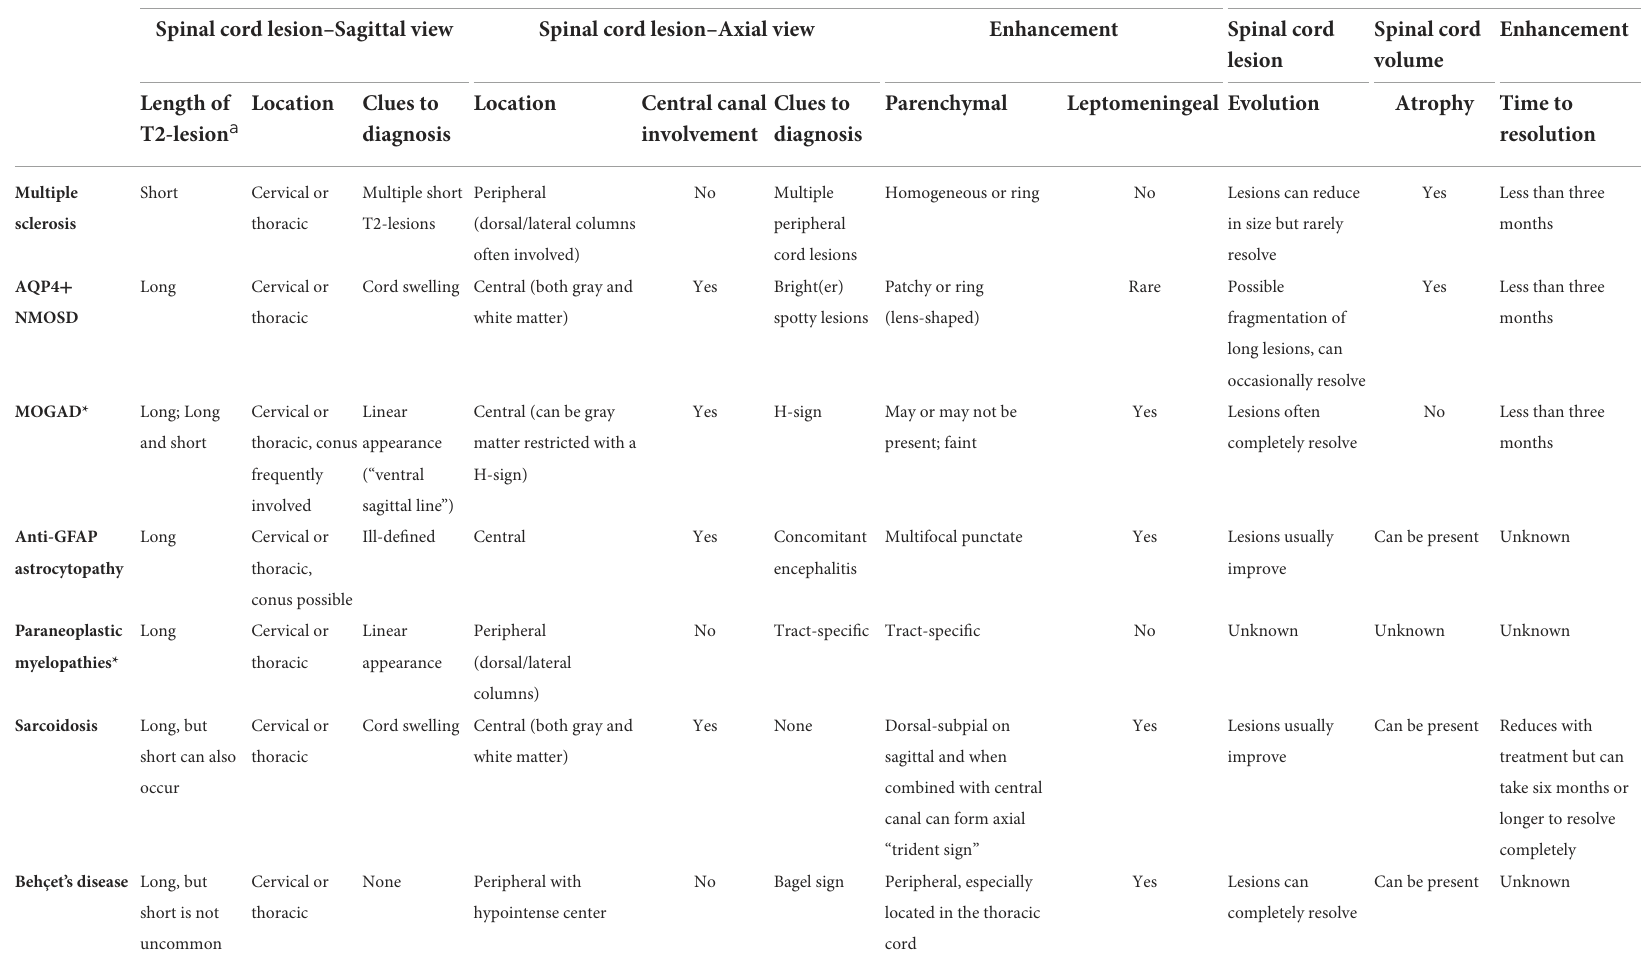
TABLE 2 Summary of radiological features in the main causes of inflammatory